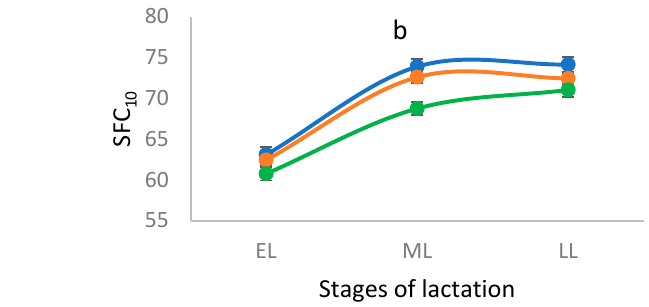
Figure 3. Solid fat content at 10 °C (SFC 10 ) for genotypes CC (….), CT ( …. ), and TT ( …. ) in cows milked once a day ( a ), and for genotypes CC ( — ), CT ( — ) and TT ( — ) in cows milked twice a day ( b ) during the production season 2020–2021. EL = early lactation (<90 days); ML = mid lactation (90–180 days); LL = late lactation (>180 days). The vertical bars show standard errors.